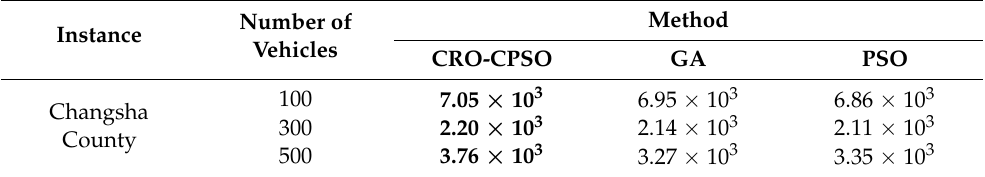
Table 3. Best Fitness Values Obtained by CRO-CPSO, GA, and PSO.